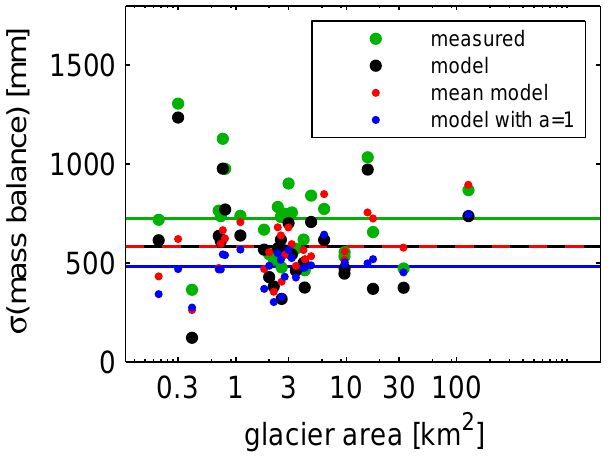
Fig. 3. Standard deviation of the annual mass balance plotted against the area of the glaciers. Green dots show MB measured , black dots show the values of the glaciers selected based on the cross val- idation procedure. Blue dots show the results for a = const . = 1, red dots show the result of the mean model. Horizontal lines show the respective means; the red line is dashed so that the black line is visible.